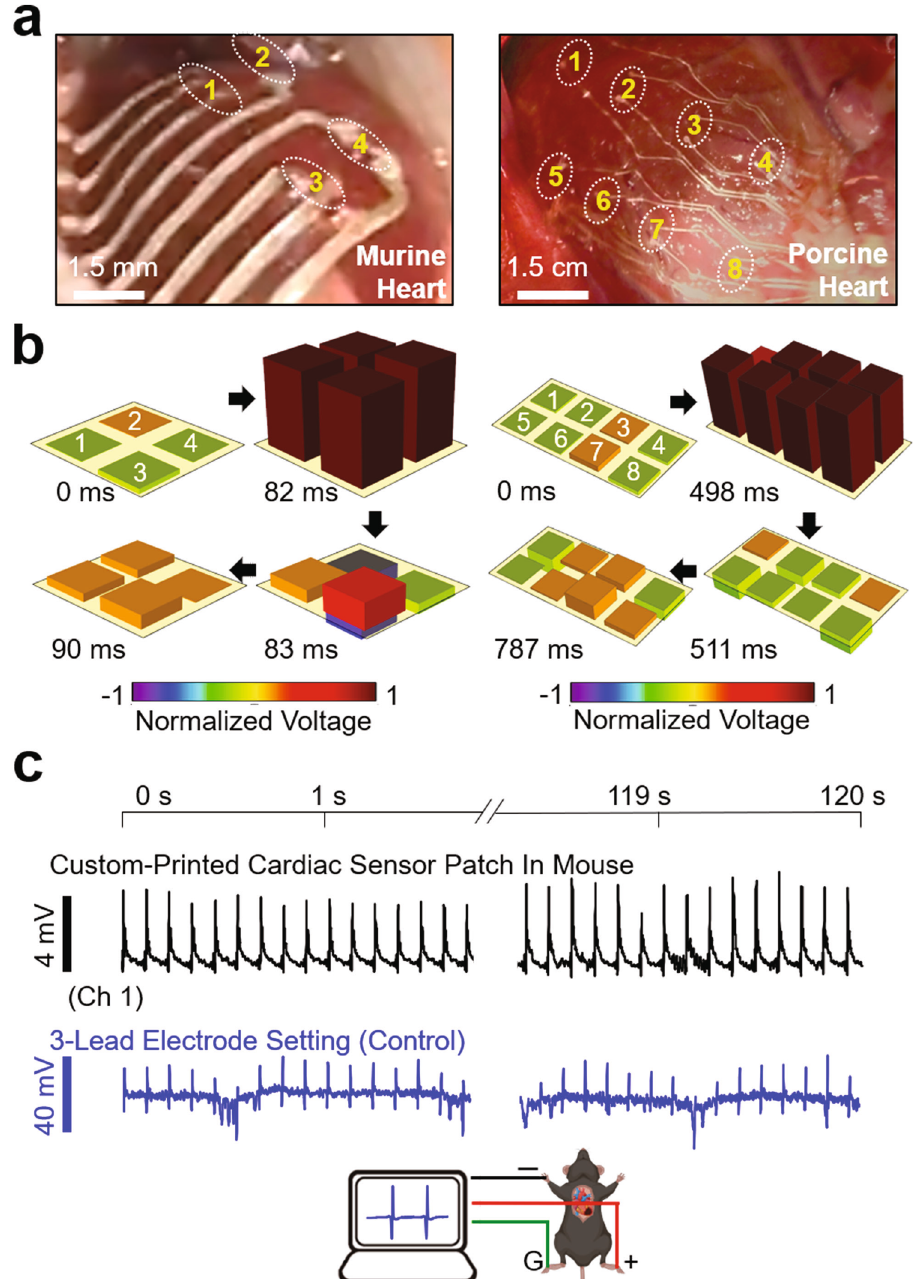
Fig. 4 Spatiotemporal recording of epicardial ECG signals in vivo. a Photographs of the custom-printed sensor arrays placed on the epicardial surface of a murine (left panel) and porcine heart (right panel). b Post-processed 3D data of the spatiotemporally recorded murine (left panel) and porcine (right panel) ECG signals. c Simultaneously measured ECG signals using the custom-printed sensor array (top panel) and a control three-lead electrode set (bottom panel) on a murine (right panel) hearts. The degree of conformal coverage across the epicardial surface increased with the decreased thickness of the device from 300 µm to 50 µm due to a signi fi cant reduction in bending stiffness by more than 200-fold (Supplementary Fig. 12).